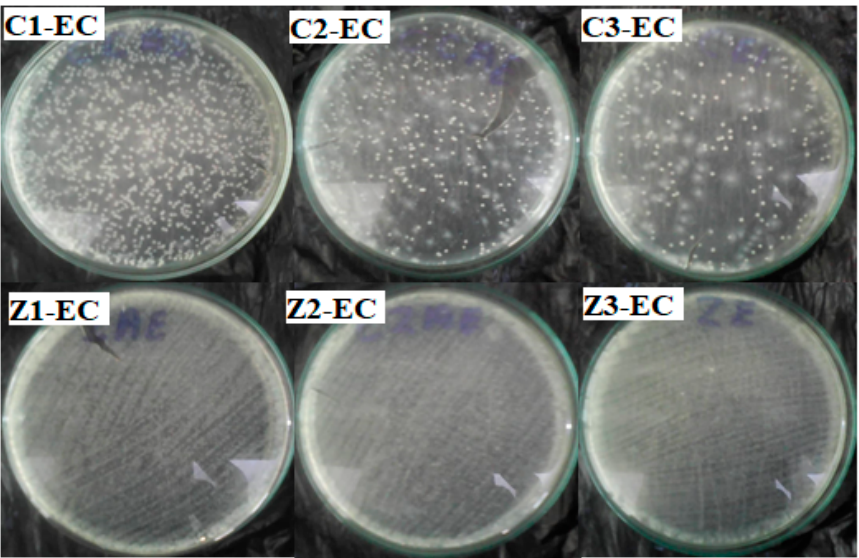
Figure 19. Antibacterial activity of clay / CuO / Ag and clay / ZnO / Ag against E. coli. C1-EC, C2-EC, C3-EC correspondingly relates to clay / CuO / Ag-1, clay / CuO / Ag-2 and clay / CuO / Ag-3 against E. coli. Z1-EC, Z2-EC, Z3-EC correspondingly relates to clay / ZnO / Ag-1, clay / ZnO / Ag-2 and clay / ZnO / Ag-3 against E. coli.